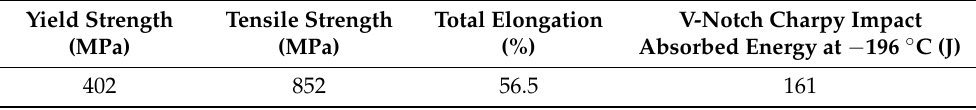
Table 3. Mechanical proprieties of the base material.